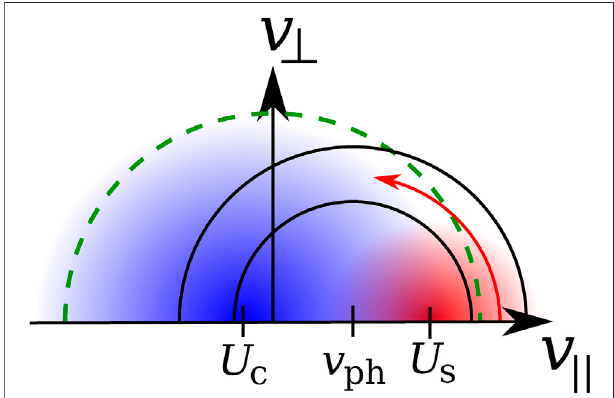
FIGURE 10 | Schematic illustration of the quasi-linear diffusion in the oblique fast-magnetosonic/whistler instability and in the lower-hybrid fan instability. The blue shaded area represents the core electron population with bulk velocity U c , and the red shaded area represents the strahl population with bulk velocity U s . The black semi-circles represent Eq. 17 for oblique fast-magnetosonic/whistler waves or lower-hybrid waves with parallel phasespeed v ph .Thediffusive fl uxofcyclotron-resonantparticlesisshownby the red arrow. The green-dashed semi-circle indicates v 2 ⊥ + v 2 (cid:2) (cid:3)